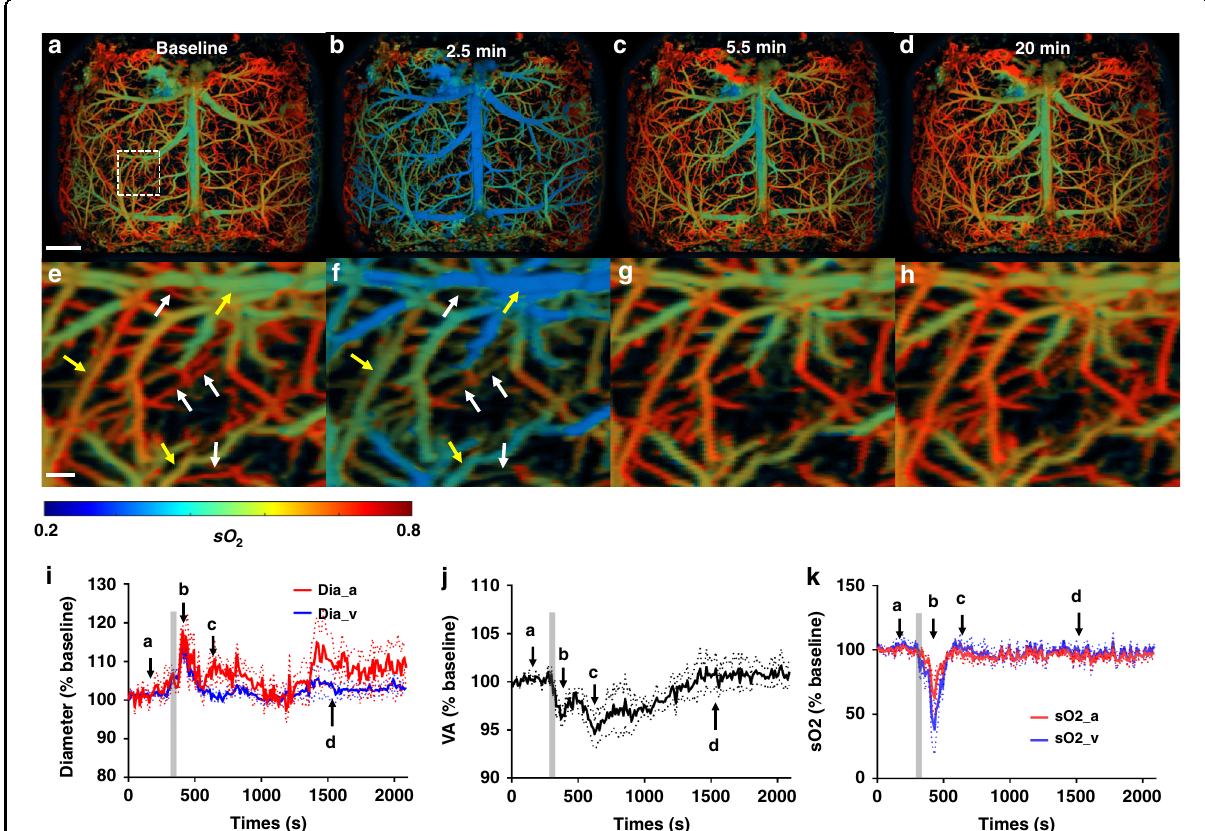
Fig. 4 UFF-PAM of brain hemodynamics in response to SNP. a – d sO 2 images of the entire cortex of the mouse brain at baseline, as well as 2.5, 5.5, and 20 min after SNP injection. e – h Close-up sO 2 images at the respective time points, as indicated by the white dotted box in ( a ). The yellow arrows point to the representative dilated vessels, and the white arrows point to the representative constricted microvessels. i The average diameter changes of arteries and veins. The grey area represents the duration of SNP injection. j Vessel area change of the whole cortex. k The average sO 2 change of arteries and veins. The arrows in ( i – k ) represent the time points corresponding to ( a – d ). N = 3. The data in ( i – k ) are shown as mean ± s.e.m. Scale bar, 1 mm for ( a – d ), and 100 μ m for ( e – h